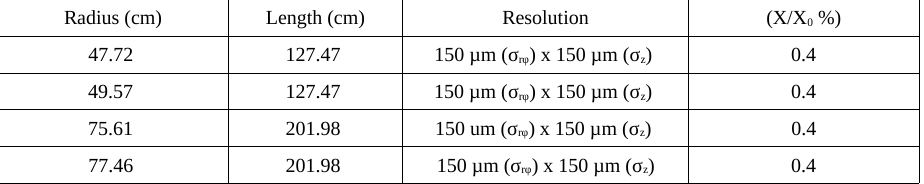
Table 3. The geometric parameters of Micromegas Barrel Layers [10].